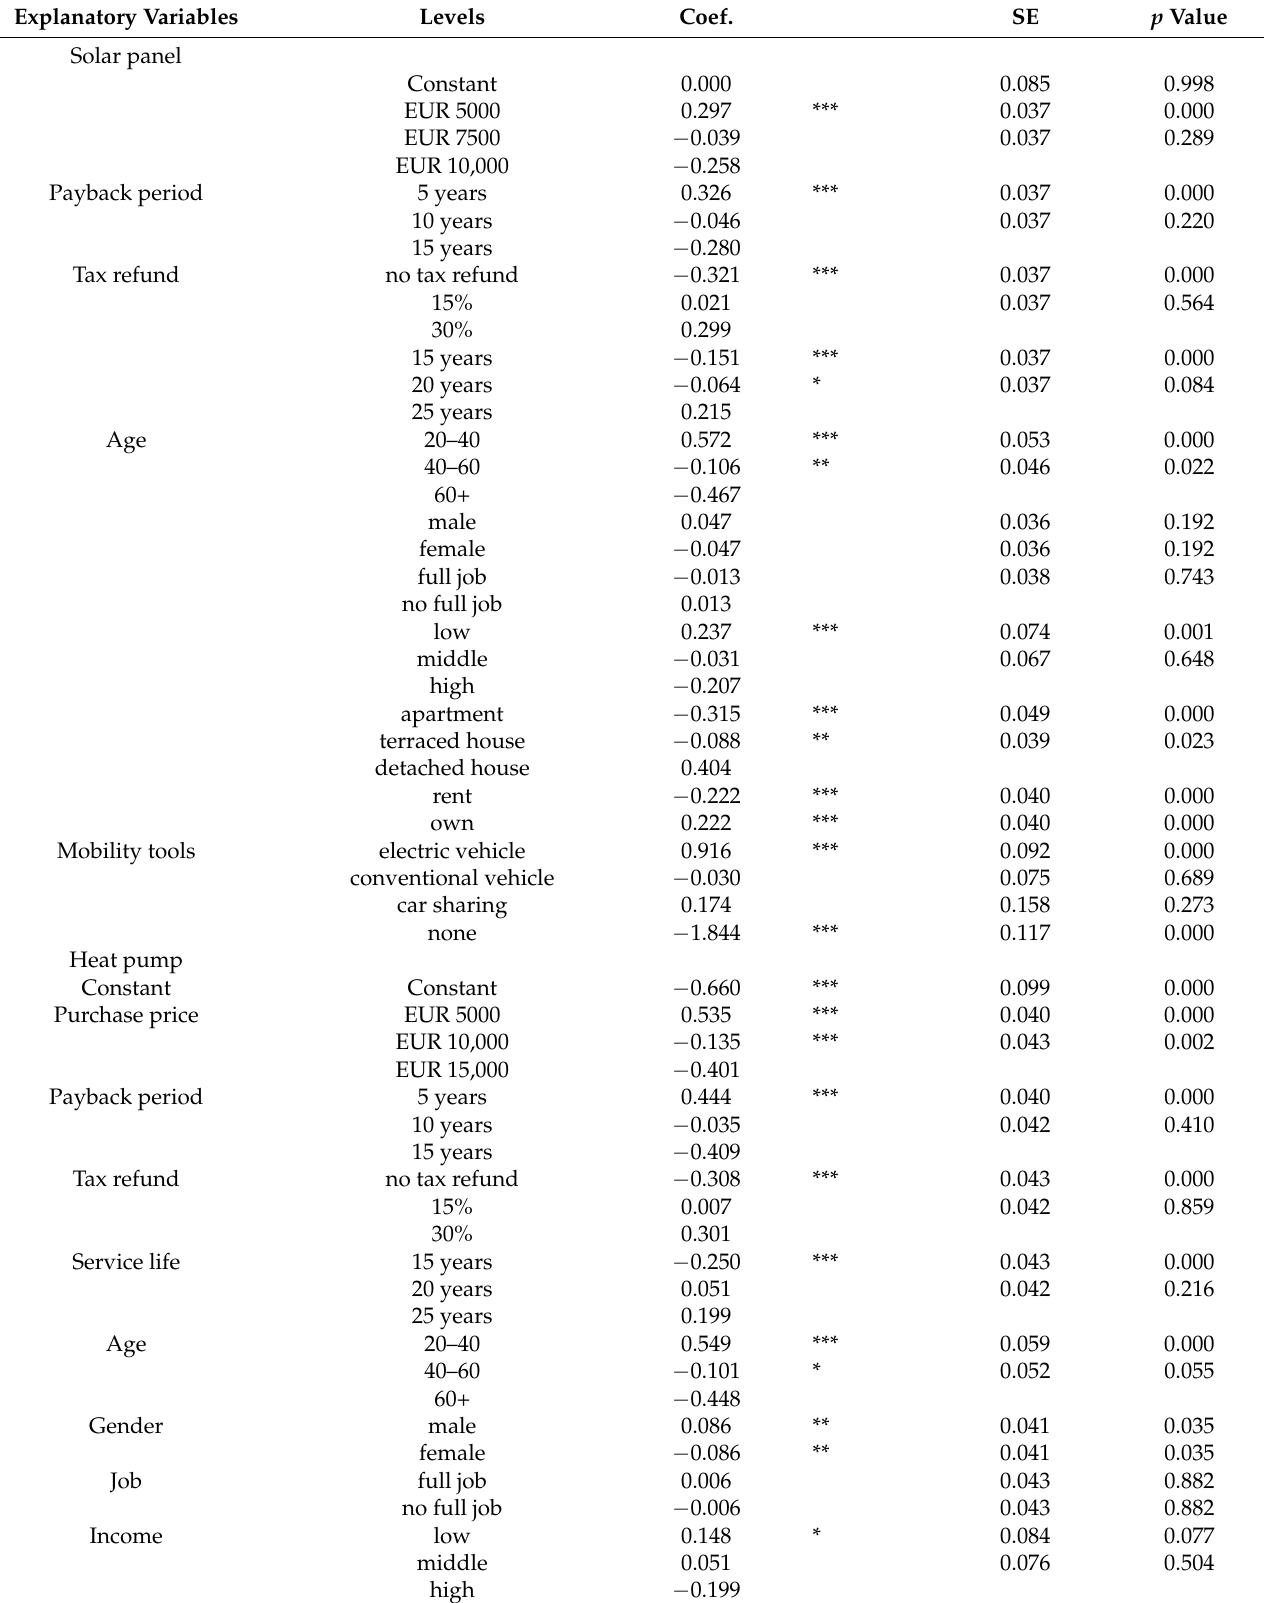
Table 5. Estimation results of Model